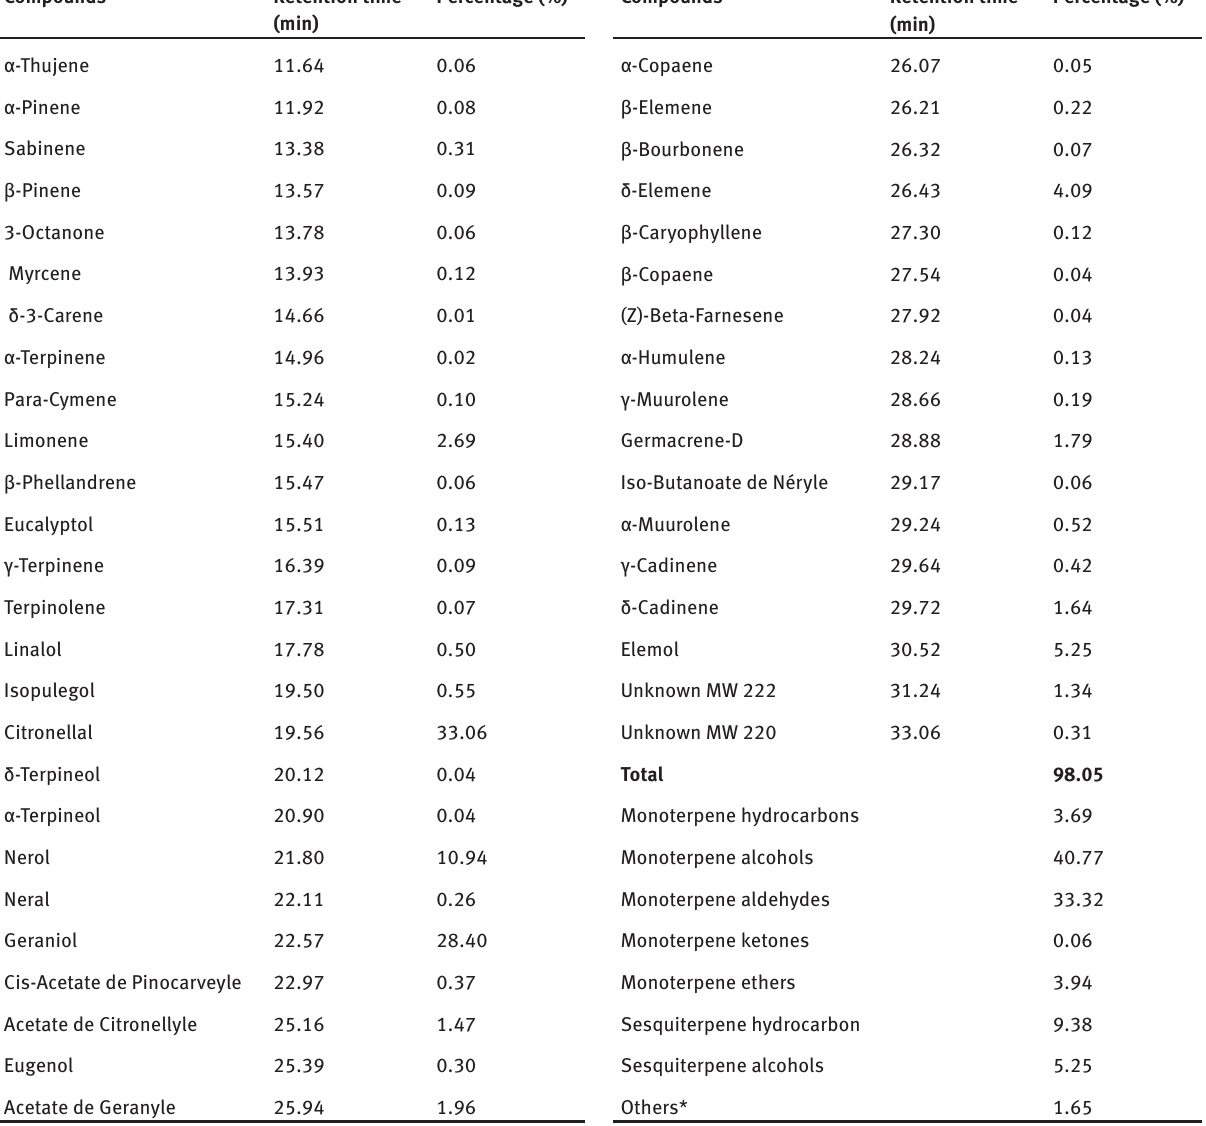
Table 1: Chemical composition of essential oils of Cymbopogon nardus.